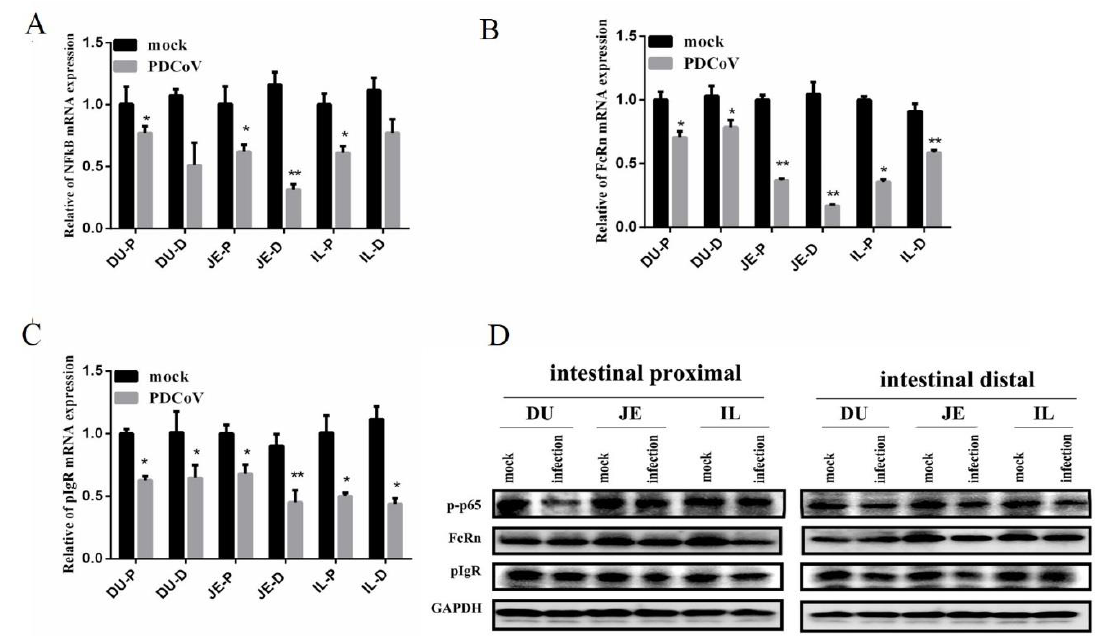
Figure 5. Expressions of nuclear factor-kappa B(NF-kB), neonatal Fc receptor (FcRn) and polymeric immunoglobulin receptor (pIgR) mRNA expression in the small intestinal mucosa of piglets induced by PDCoV CHN-JS-2017 at 4 dpi. The mRNA levels of NF-kB ( A ), FcRn ( B ), and pIgR ( C ) in the small intestinal mucosa were determined individually in each animal by RT-qPCR. All data are expressed as the mean ± SEM of three independent experiments. * p < 0.05, ** p < 0.01, relative to the mock-treated piglets. Relative amplification of the target genes expression levels was normalized to GAPDH expression. ( D ) The protein levels of NF-kB, FcRn, and pIgR at the small intestinal mucosa were determined individually in each animal by Western blot. DU-P: Duodenum proximal. DU-D: Duodenum distal. JE-P: jejunum proximal. JE-D: jejunum distal. IL-P: ileum proximal. IL-D: ileum distal.